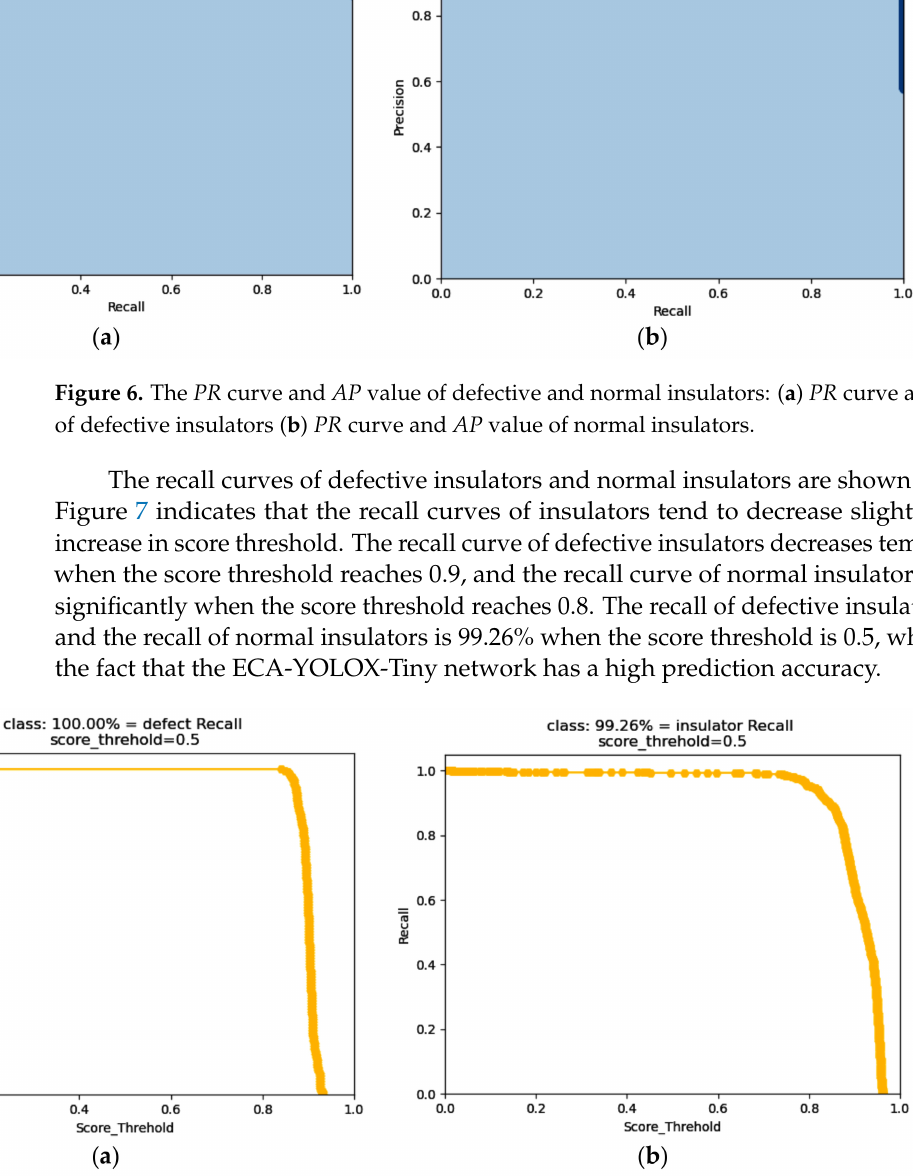
Figure 7. The recall curve of defective and normal insulators: ( a ) recall curve of defective insulators, ( b ) recall curve for normal